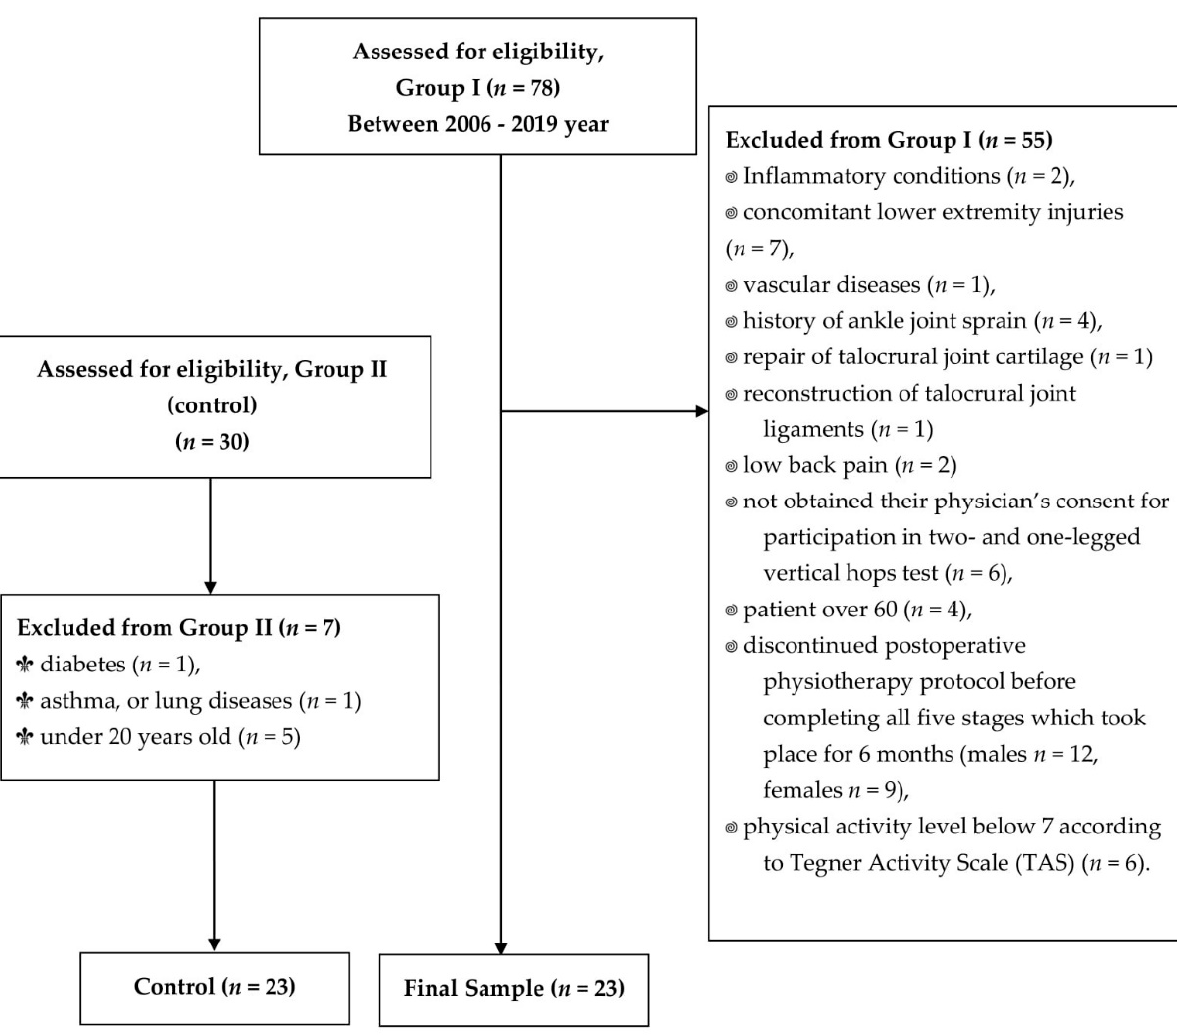
Figure 1. Flow diagram of the study; n —number of individuals. Finally, the participants that qualified for further analysis included 23 patients (males n = 23; females n = 0) after surgical suturing of the AT using Keesler’s technique, who were assigned to Group I. All patients, before AT rupture, participated in sport disciplines such as soccer, volleyball, and tennis. Group II included 23 males with no AT or talocrural joint injuries (Table 1). According to the TAS, the levels of physical activity for patients in Group I and Group II were 7 or higher [32]. Group I patients participated in an average of 42.22 visits (from 24 to 83 visits) as part of the 6 month supervised postoperative physio- therapy program after the surgical suturing of the AT. It was assumed that these patients participated in 42 visits (Table 1). It is worth mentioning that the physiotherapist had no impact on the number of visits, as this depended on the patients’ financial resources and commitment. The duration of one supervised physiotherapeutic session with a physio- therapist was 2 h. The studied groups were uniform in terms of age, but, statistically, they were significantly different in terms of body mass ( p = 0.019) and height ( p = 0.004). For this reason, the vertical ground reaction forces component values obtained for two- and one-legged vertical hops were normalized to body mass (relative ground reaction forces), expressed in N · kg − 1 . The comparison of patients’ body mass index (BMI) values did not reveal any statistically significant differences between the studied groups ( p = 0.312). At every stage of physiotherapy, patients were additionally guided by the physiotherapist on how to perform exercises at